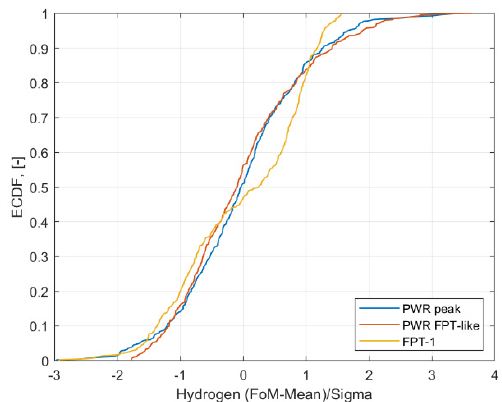
Figure 11. Empirical cumulative distribution function (ECDF) for the normalized hydrogen mass (FoM). Normalization by the mean and standard deviation.